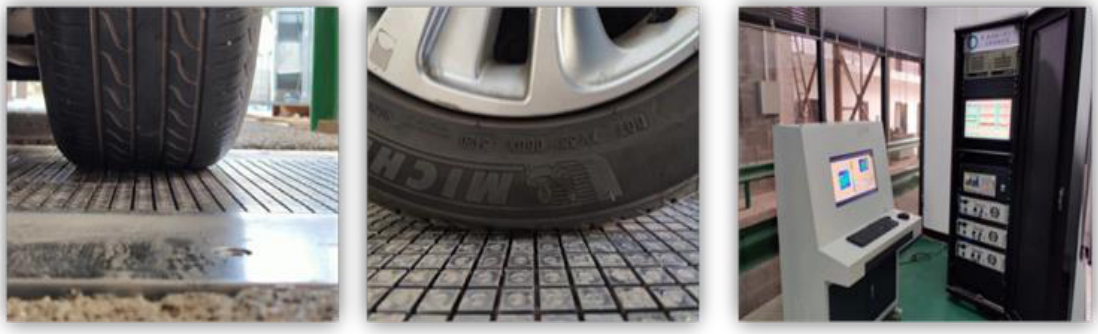
Figure 7. Real vehicle test.